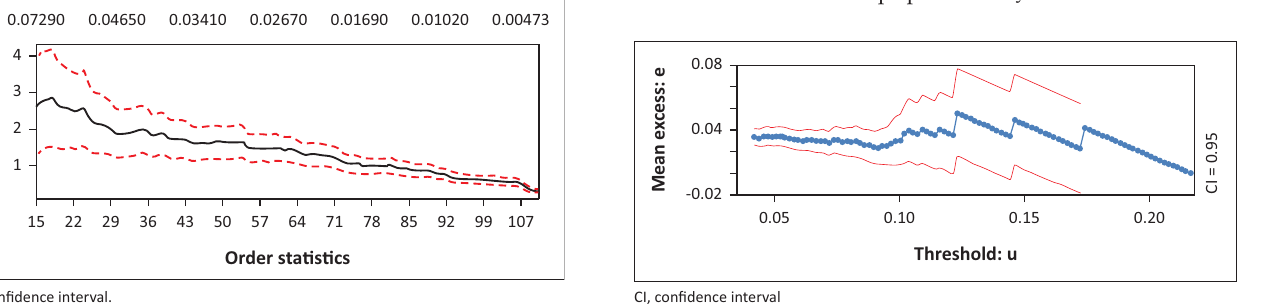
FIGURE 2: Hill plot for the left tail (positive returns or gains).